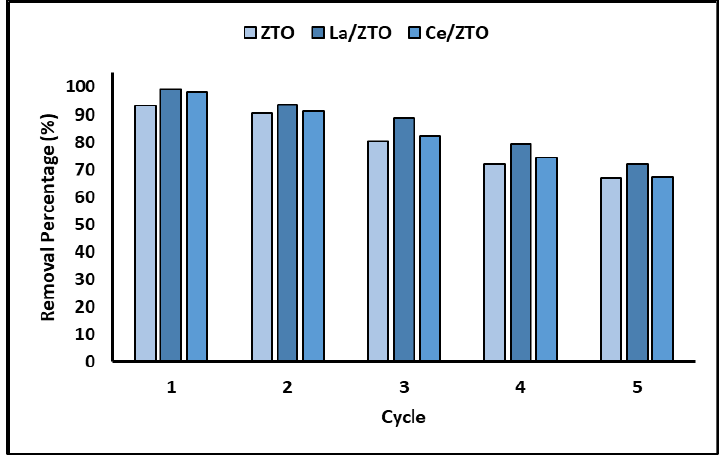
Figure 10. Percentage of cyanide removal for five successive cycles.